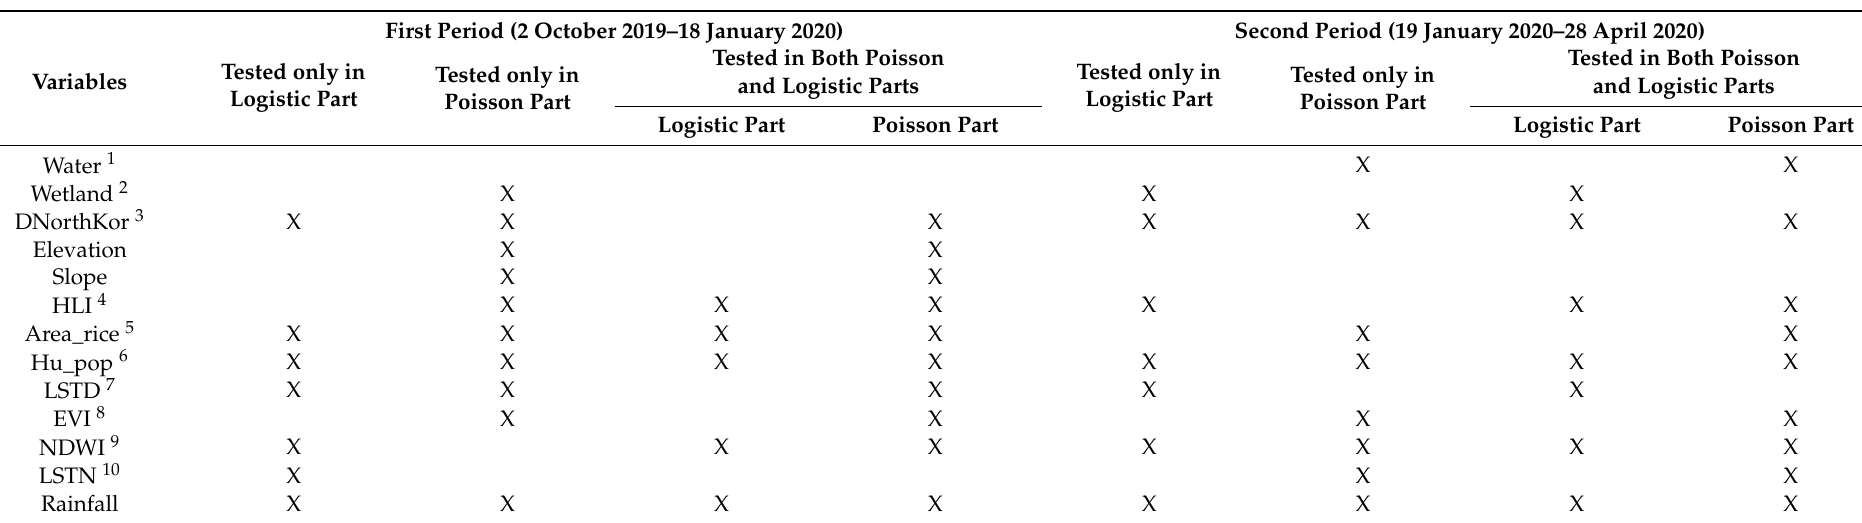
Table 1. Summary of univariable analysis for the first and second periods. A X indicates that the variable had a statistically significant association with the dependent variable in the models, with a significance threshold of